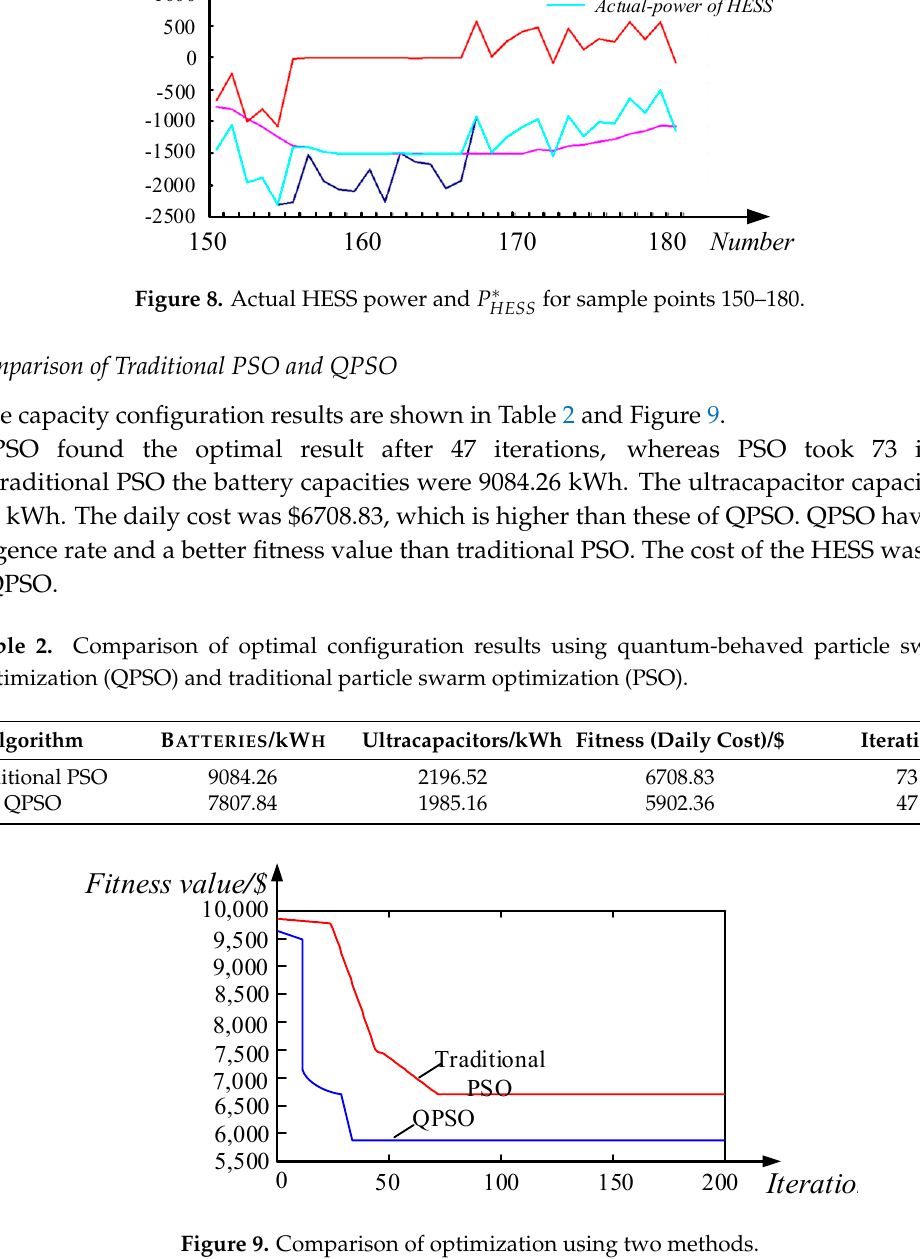
Figure 8. Actual HESS power and P *